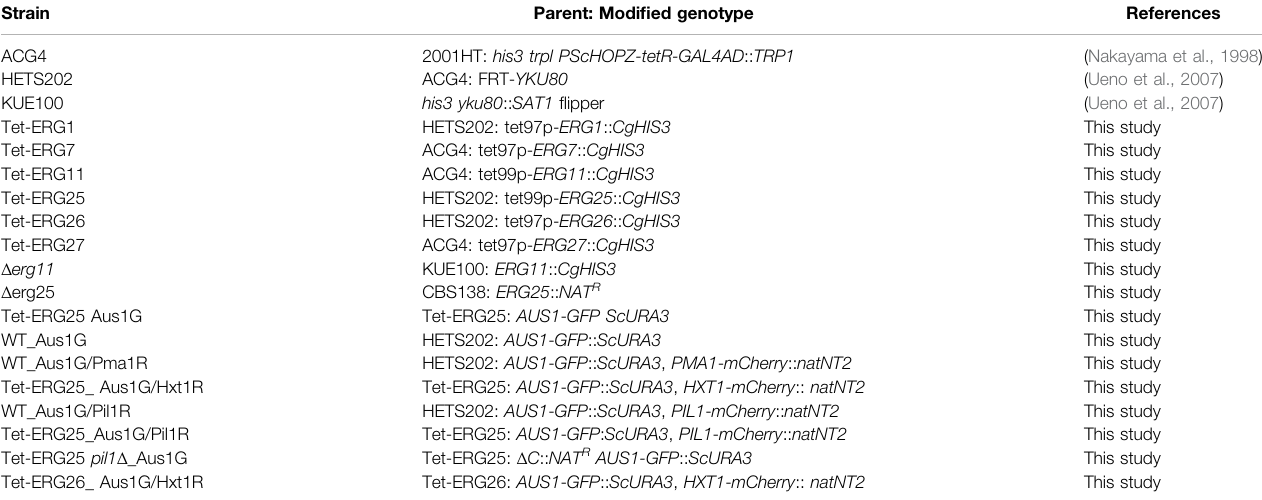
TABLE 1 | List of strains used in this